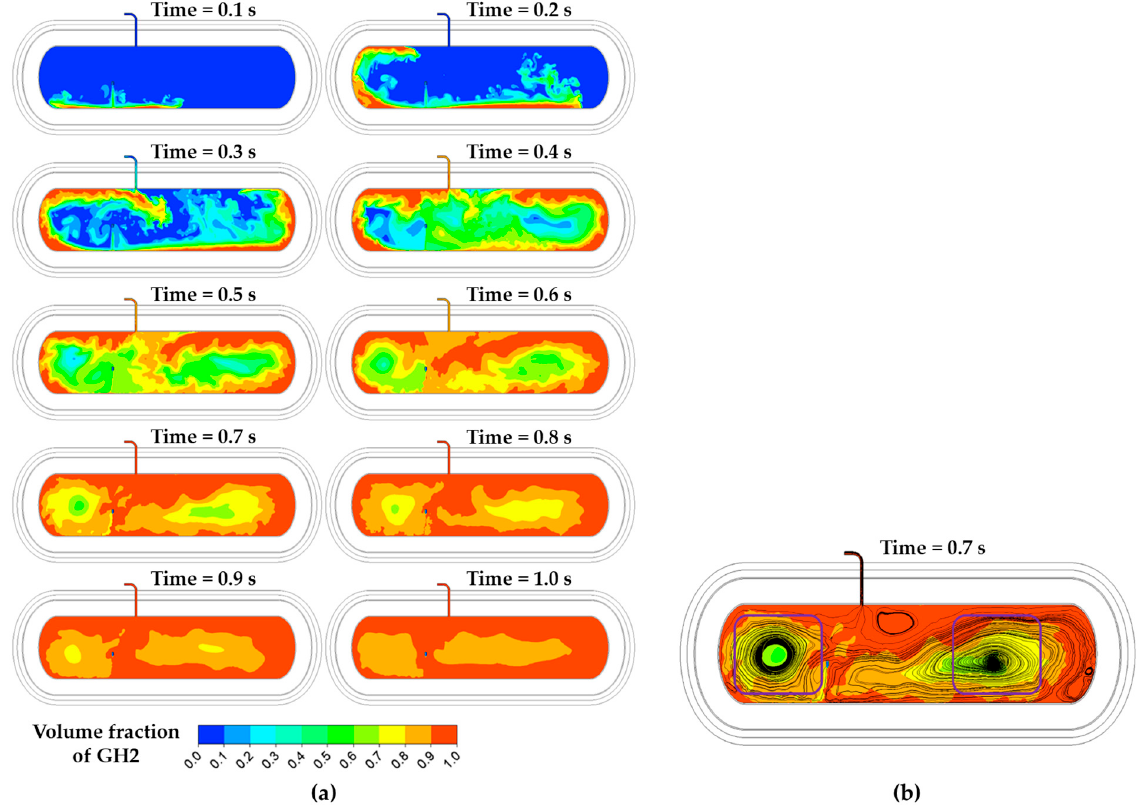
Figure 7. Distributions of the volume fractions of hydrogen gas ( a ) change according to charging process and ( b ) with streamline at 0.7 s.